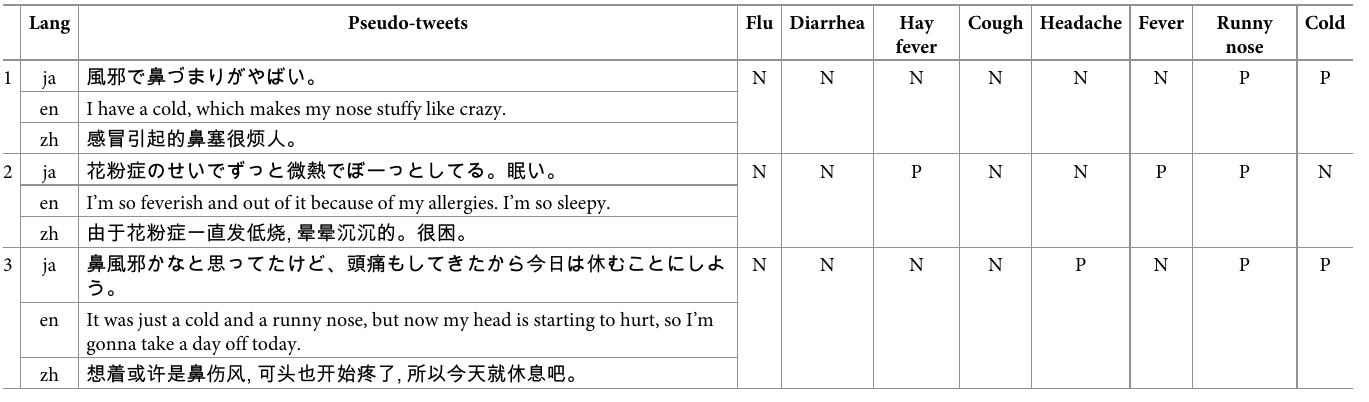
Table 1. Three examples of pseudo-tweets with the eight classes of symptoms.